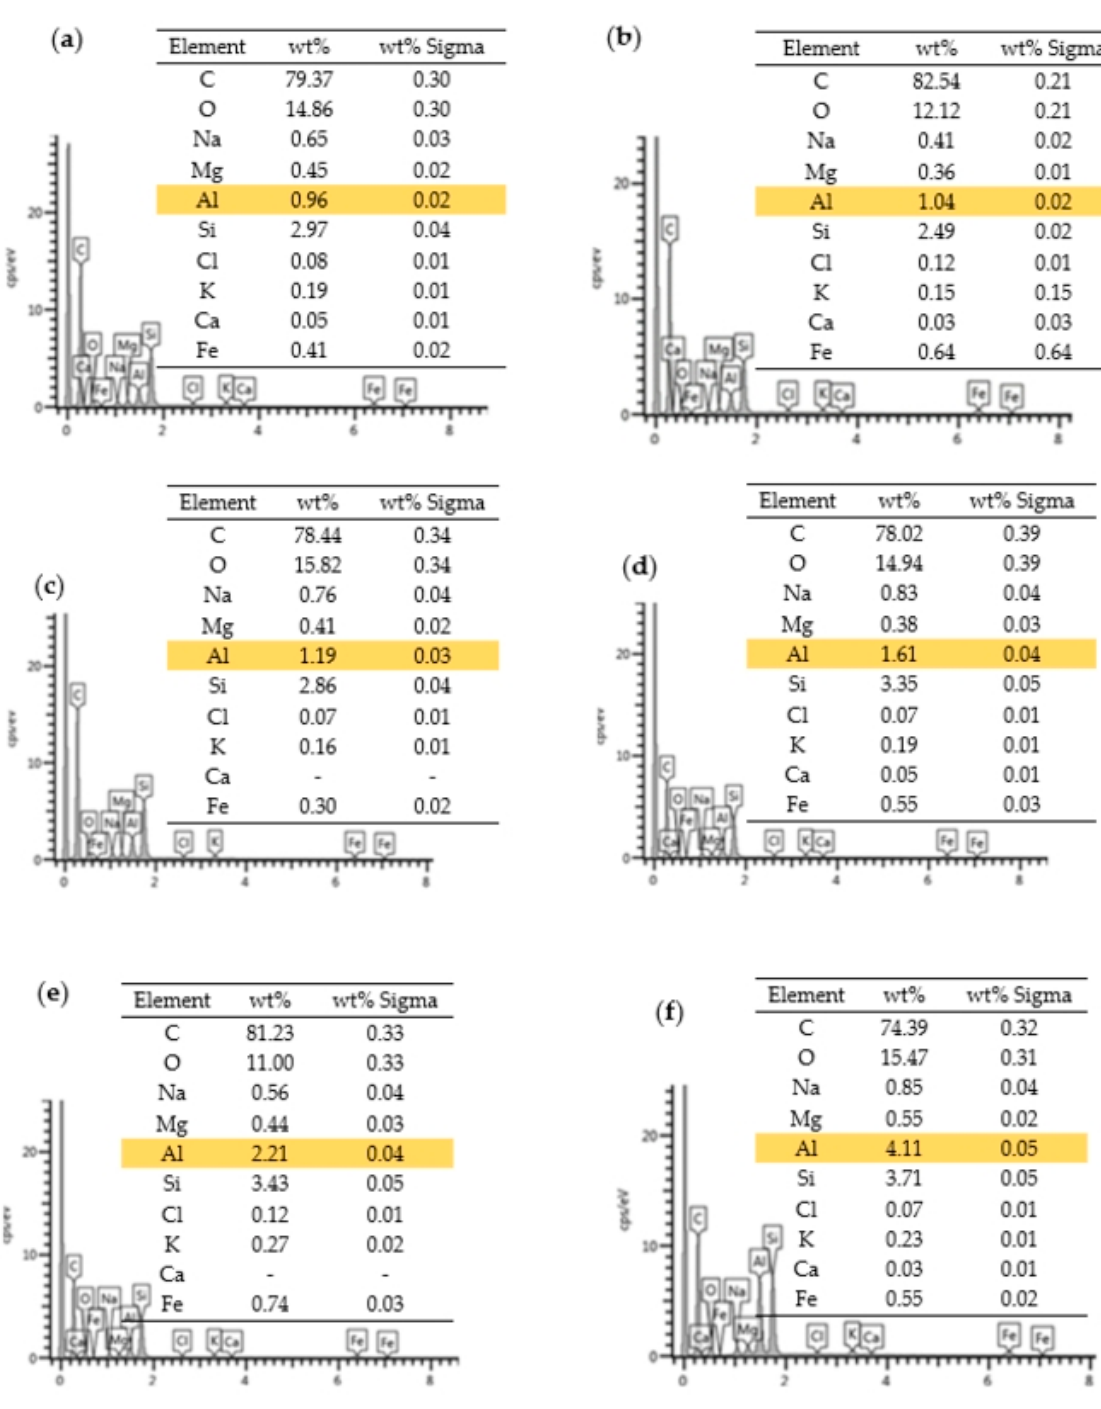
Figure 6. EDS spectra and overview of chemical composition of ( a ) epoxy matrix without Al NP and epoxy matrix with ( b ) 0.5%, ( c ) 0.75%, ( d ) 1.0%, ( e ) 3.0%, and ( f ) 6.0% Al NP.